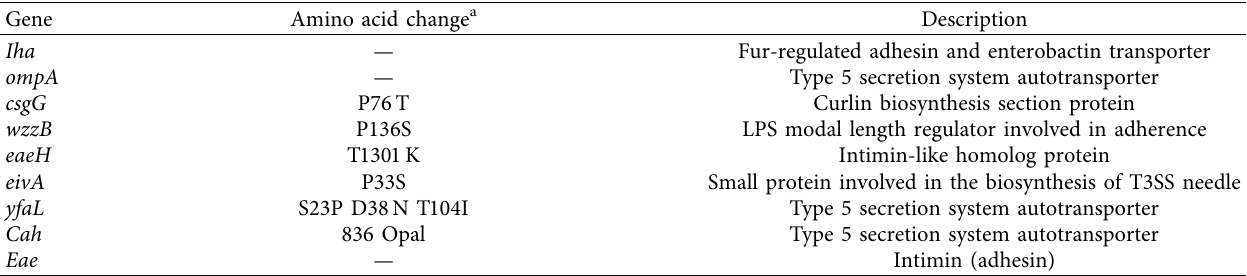
Table 1: Details of the nonfimbrial genes of interest.